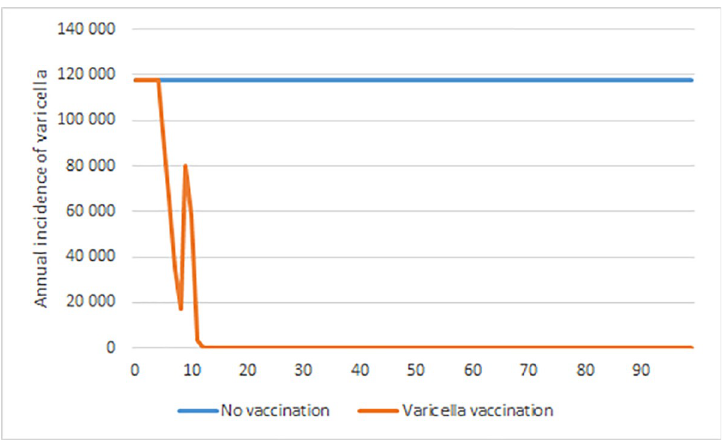
Fig 2. Annual number of varicella cases with varicella vaccination. All age groups, with and without varicella vaccination, over a 100-year time horizon.